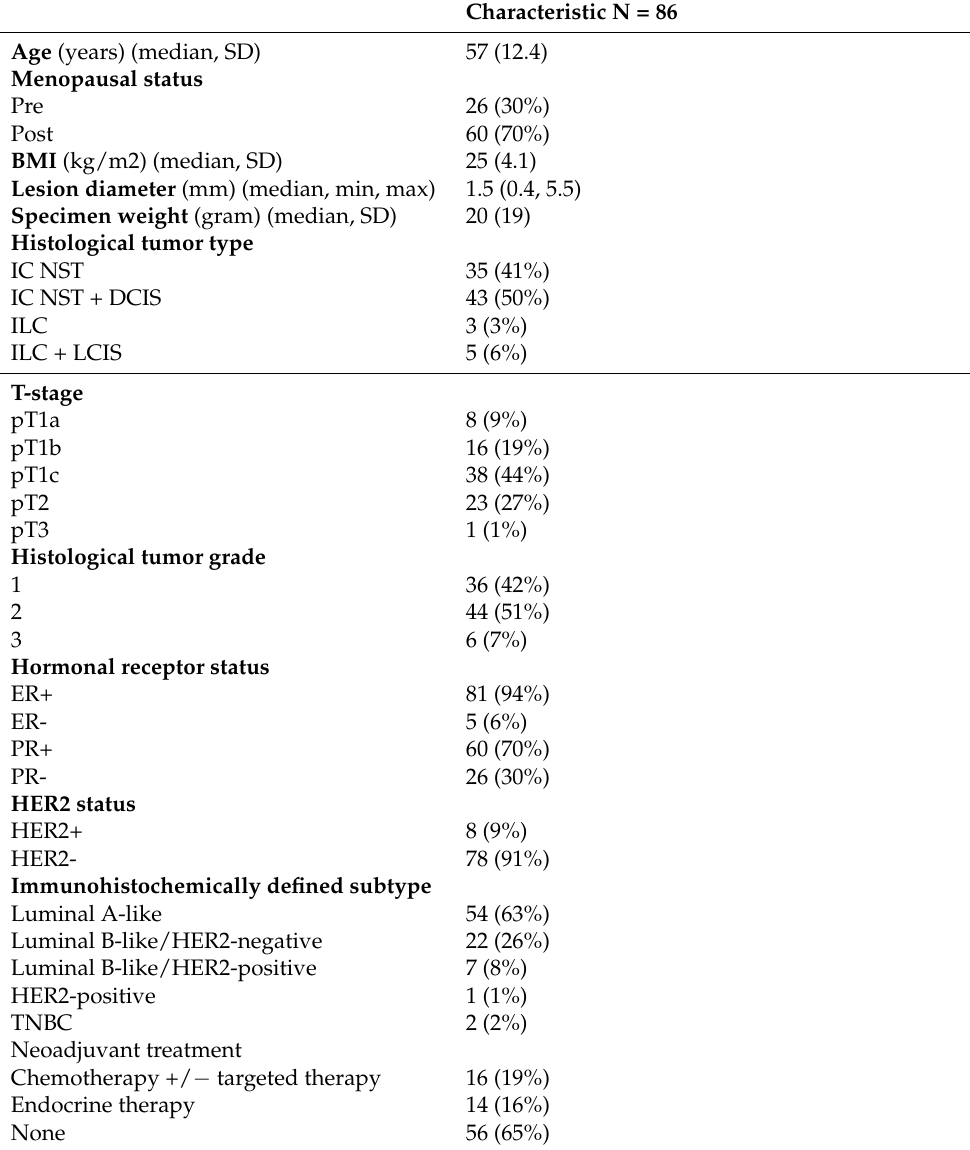
Table 1. Tumor and patient